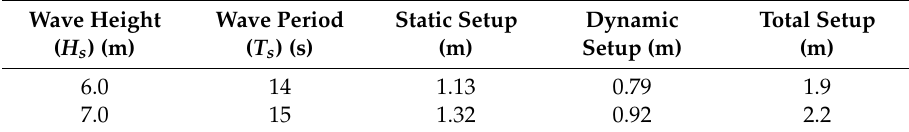
Table 2. Significant heights ( Hs ) and mean wave periods ( Ts ), corresponding to the return period (RP) of 10 (line 1) and 40 years (line 2).